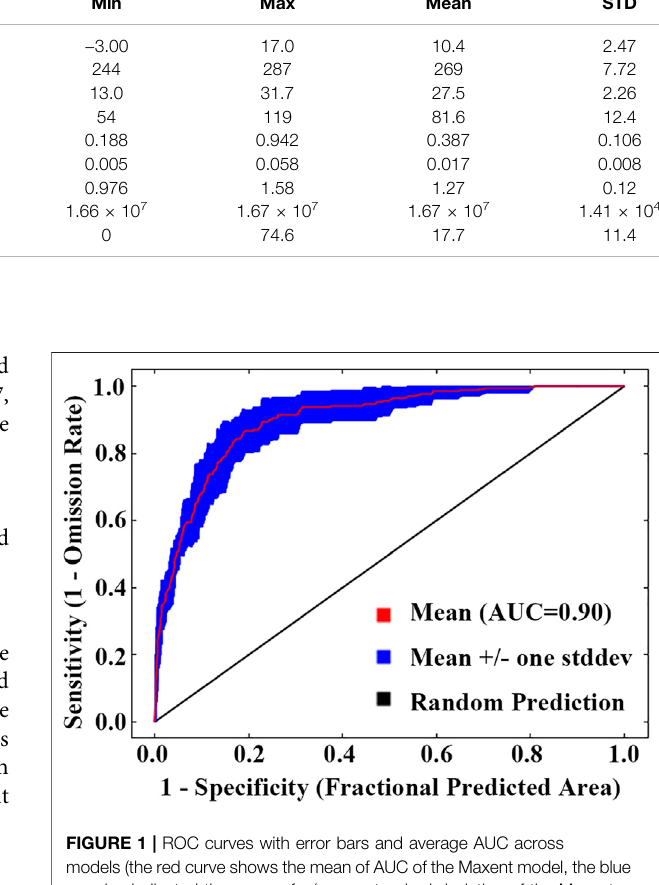
TABLE 1 | Statistics of nine signi fi cant environmental variables for modeling the habitat suitability distribution of Jerusalem artichoke. Code